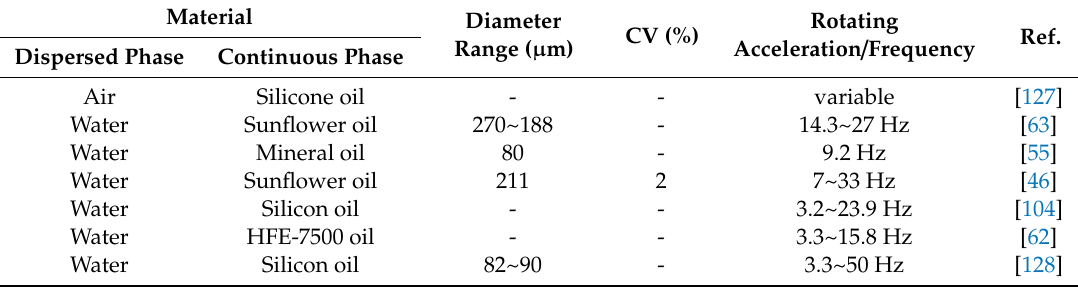
Table 3. Summary of reported crossflow